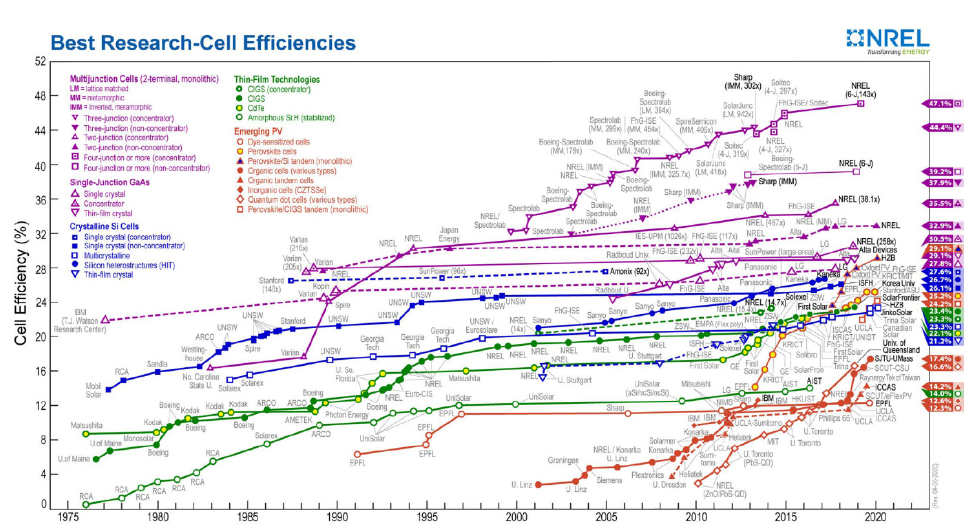
Fig. 10. – Best Research-Cell efficiency reported by the National Renewable Energy Laboratory (NREL, USA) https://www.nrel.gov/pv/cell-efficiency.html